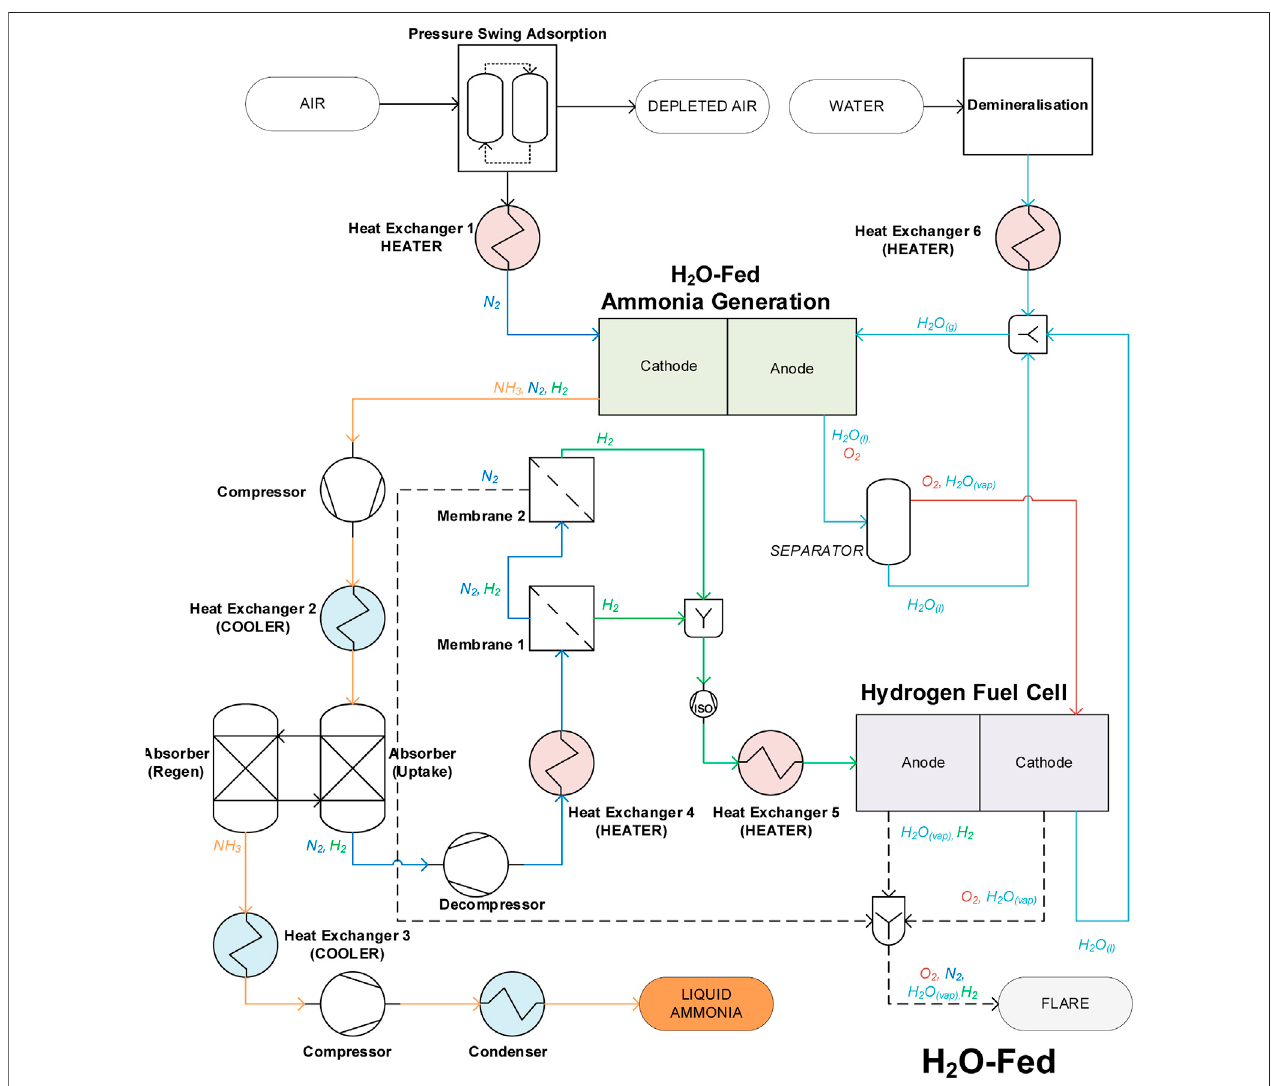
FIGURE 5 | Water fed cell process fl ow arrangement (H 2